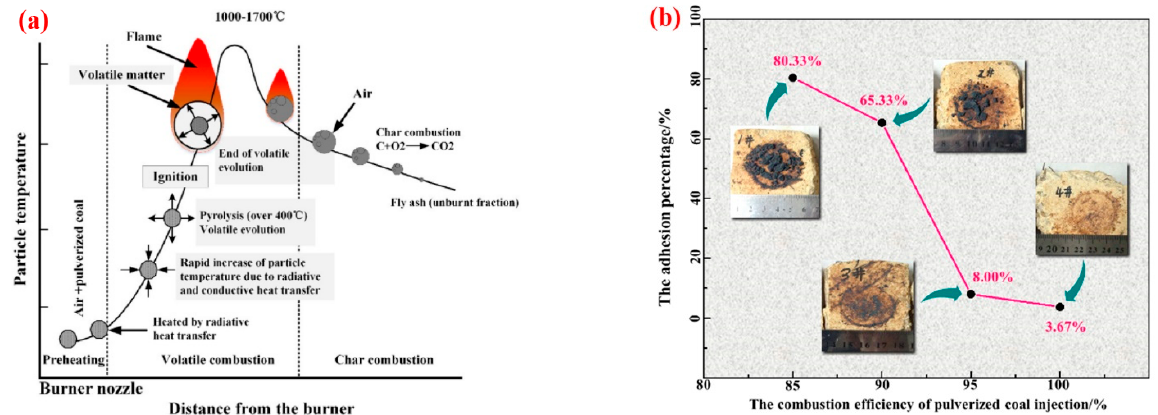
Figure 8. Effect of pulverized coal combustion efficiency, including ( a ) illustration of combustion phenomena of pulverized coal [26]; ( b ) the adhesion performance of pulverized coal with 85–100% combustion efficiency [43] .